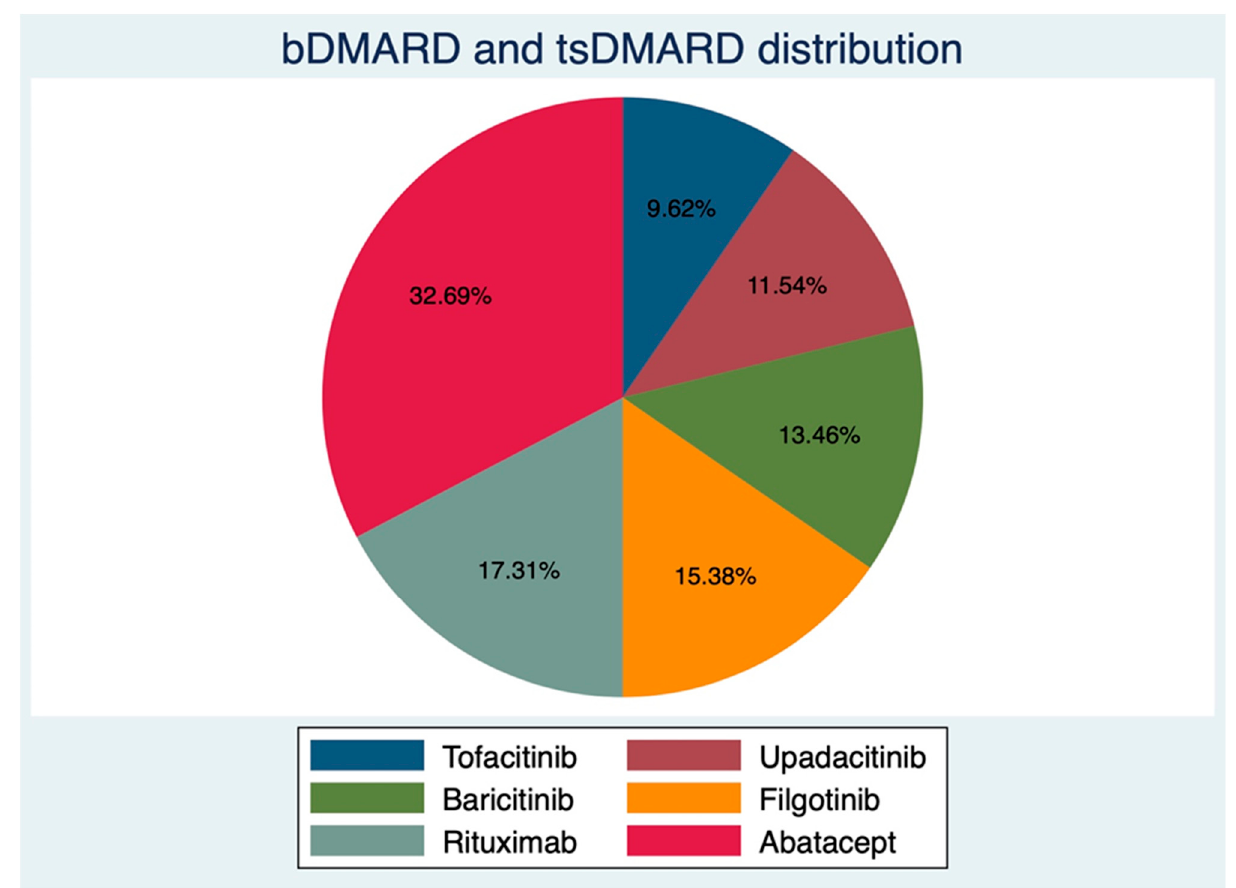
Figure 1. Distribution of biological and targeted synthetic disease-modifying anti-rheumatic drugs. Only 2 patients (3.85%) reported previous HZ, with both in the bDMARDs group. No patients had ever received the live zoster vaccine. At RZV baseline, the anti-VZV IgG serum level was similar between groups (1000.66 ± 140.684 mIU/mL for those on bDMARDs vs. 843.96 ± 114.70 mIU/mL JAKi patients, p = 0.39, Figure 2). RZV reactogenicity at the first shot is shown in Table